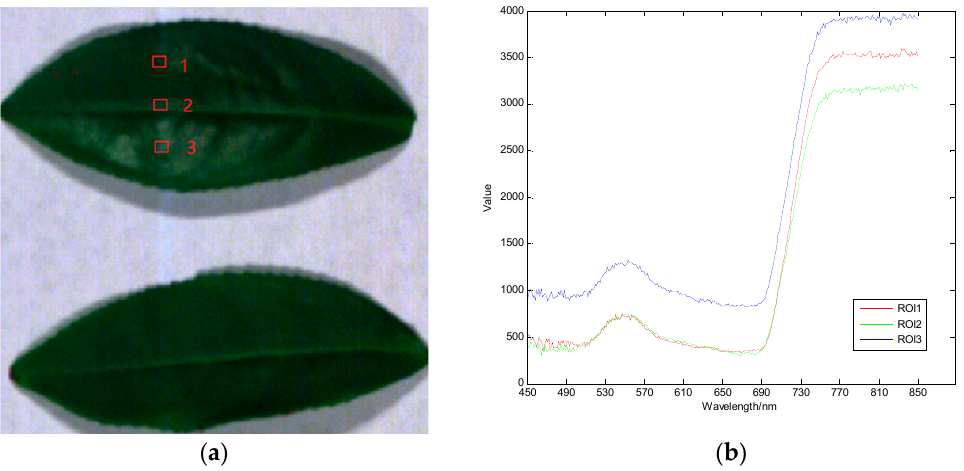
Figure 2. Spatial image of hyperspectral raw data and three regional spectral curves. ( a ) Original data space image; ( b ) The averaged spectrum for each ROI.